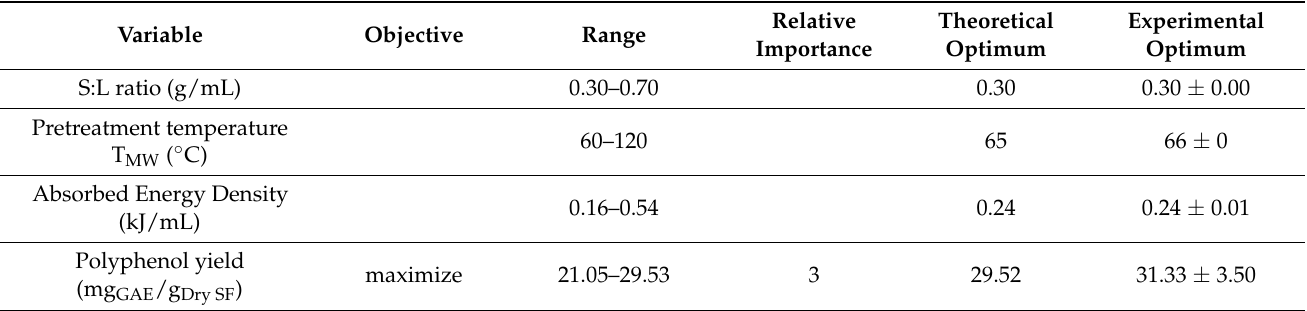
Table 7. Optimization